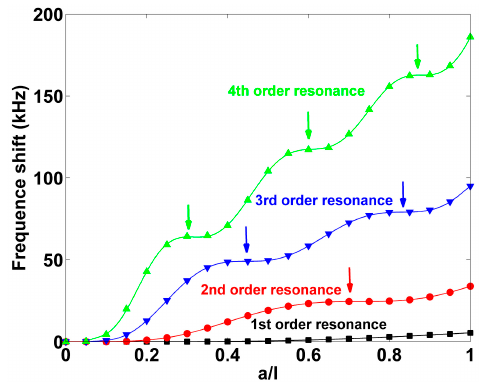
Figure 4. The behavior of frequency shift of the cantilever with different mass distribution where ρ m A m / ρ 0 A 0 = 1.